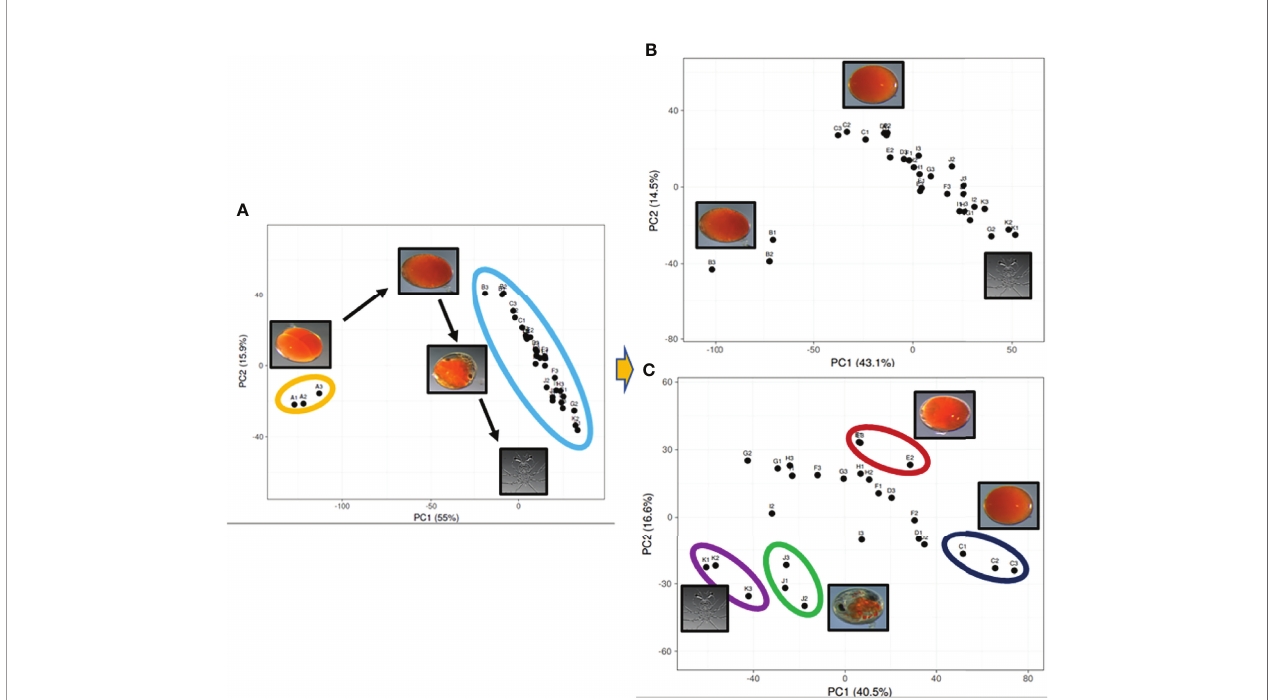
FIGURE 2 | Principal component analysis visualizing the top 1000 expressed genes across the 11 stages of embryo development derived from the Panulirus ornatus transcriptome. The top 1000 genes are the same across all three plots, the number of samples and stages is receding with 33 (11) (A) , then 30 (10) (B) , 27 (9) (C) , where the two main principal components explain diminishing, yet signi fi cant variation at 55%, 43.1% and 40.5% for PC1 and 15.9%, 14.5% and 16.6% for